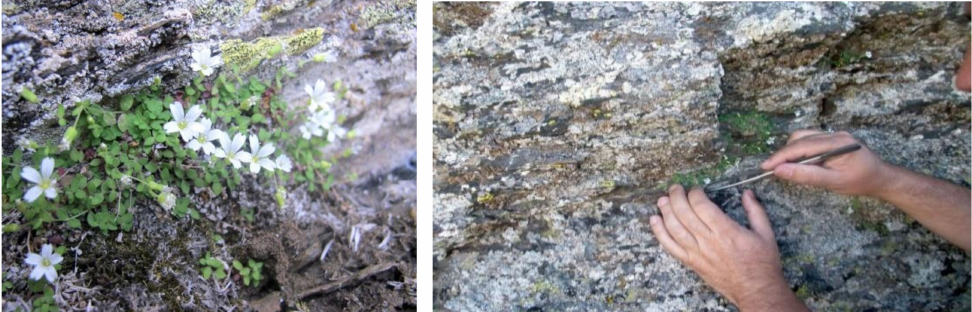
Figure 1. Moehringia fontqueri , plant detail ( left ) and sample collection method ( right ).